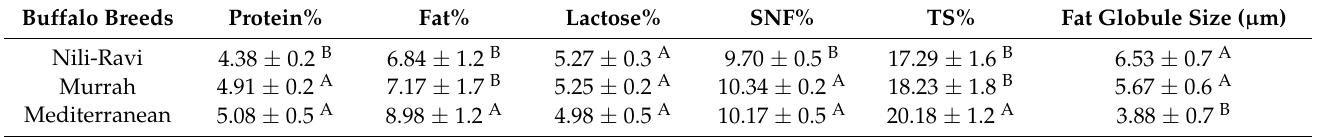
Table 1. Chemical composition and fat globule size of milk from different buffalo